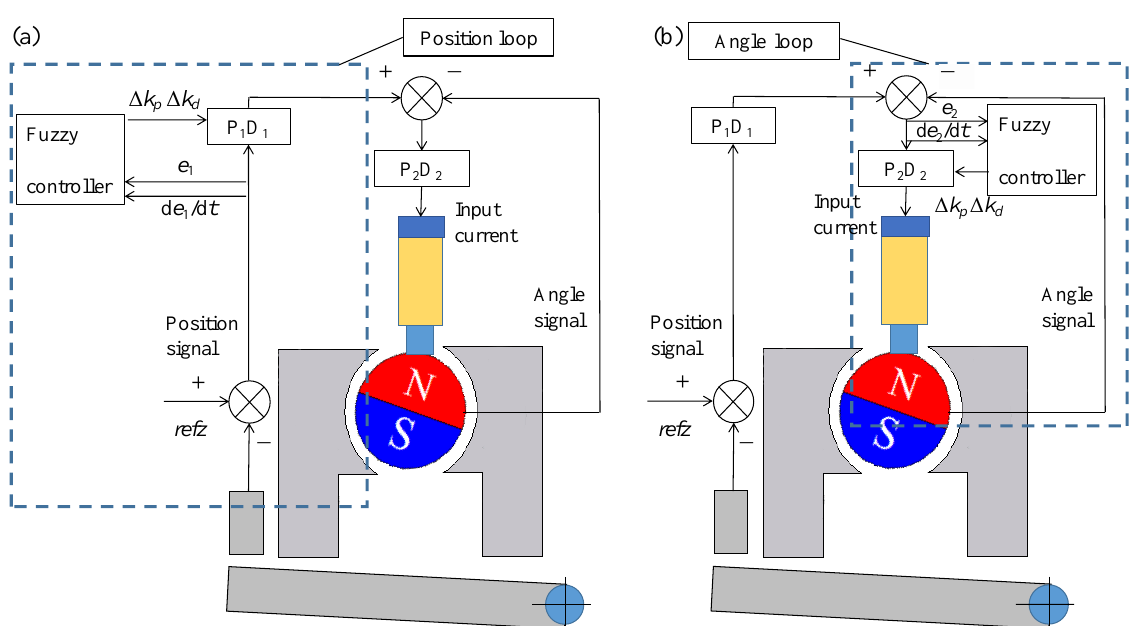
Figure 4. ( a ) The position loop fuzzy cascade control; ( b ) the angle loop fuzzy cascade control.